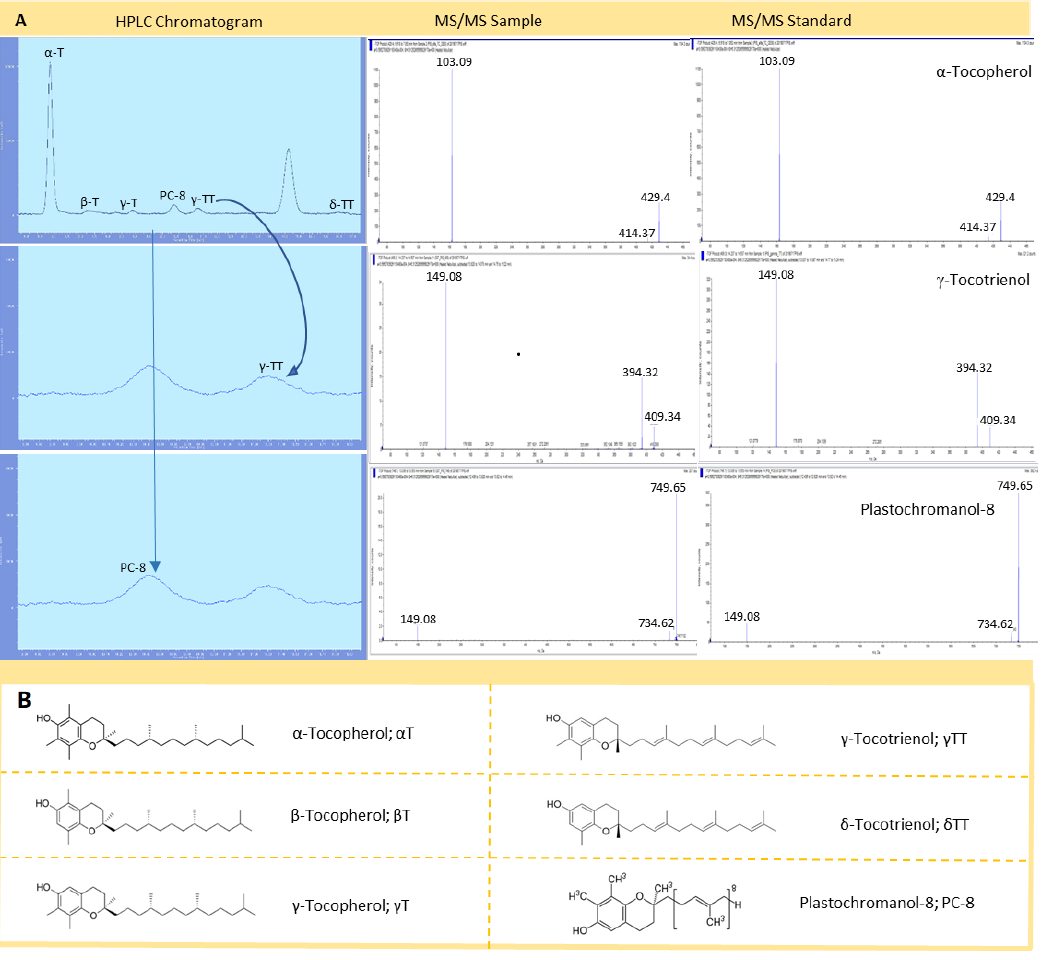
Figure 1. ( A ): Separation (by HPLC, left ) and identification (by liquid chromatography coupled to electrosprayionizationmassspectrometryintandem[LC-ESI-MS / MS], center and right )oftocochromanols in Bacon avocados. ( B ): Chemical formula of tocochromanols identified in Bacon